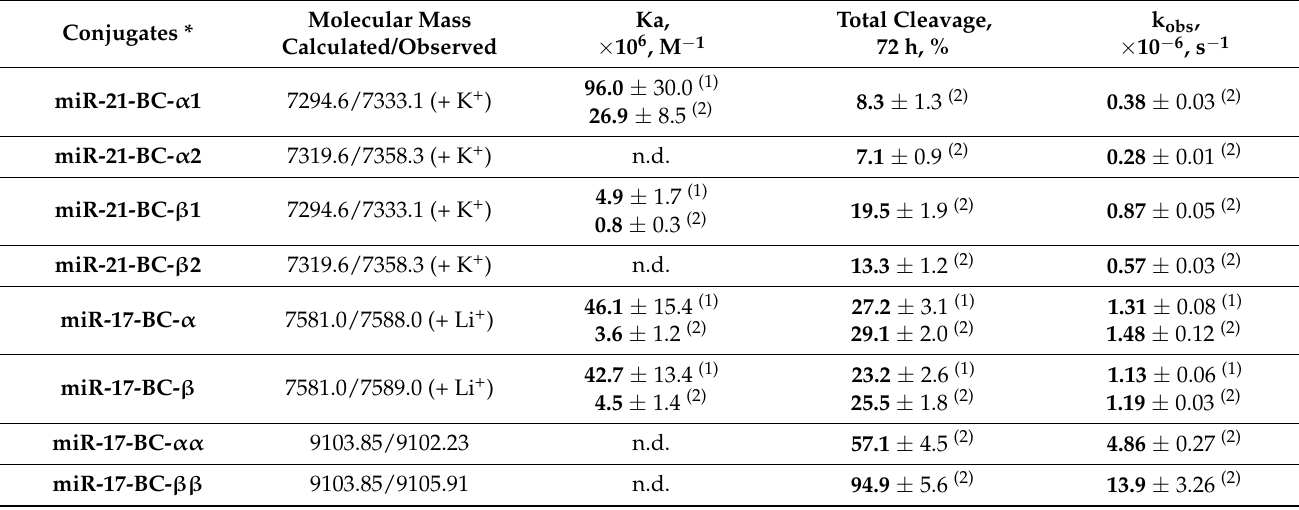
Table 1. The main hybridization and cleavage properties of bulge-loop-forming